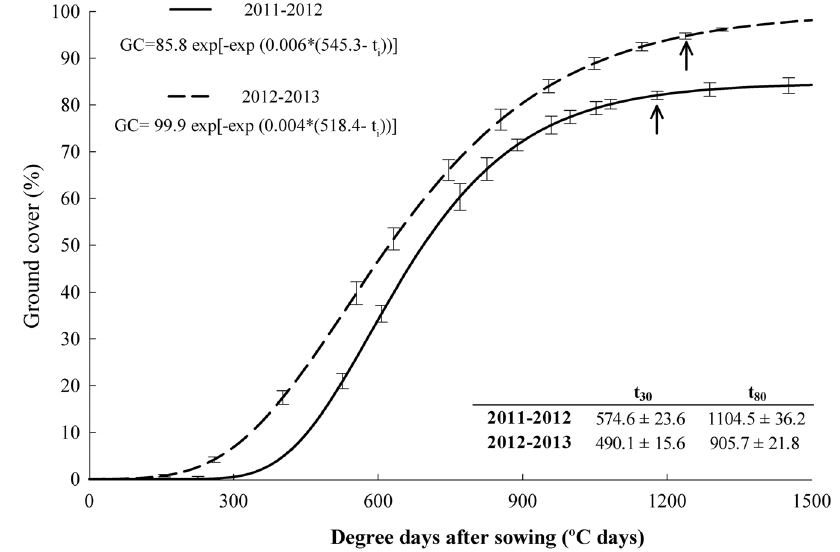
Figure 2. Ground cover (GC) development during the cover crop growth period in both experimental seasons. Arrows show the first kill date. Lines represent the Gompertz model adjusted to the observed values. Fitted models and the thermal time until the ground cover reaches 30 and 80% (t 30 and t 80 ) are shown.